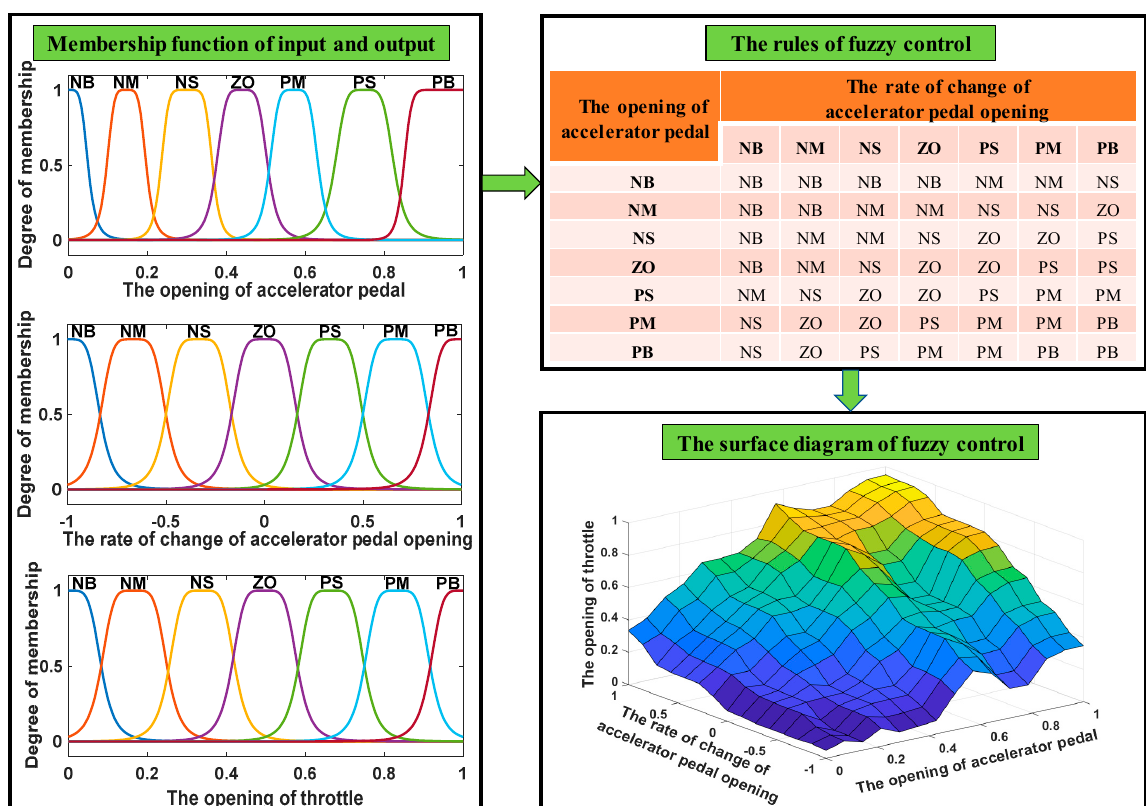
Figure 5. The fuzzy controller for driver intention recognition.